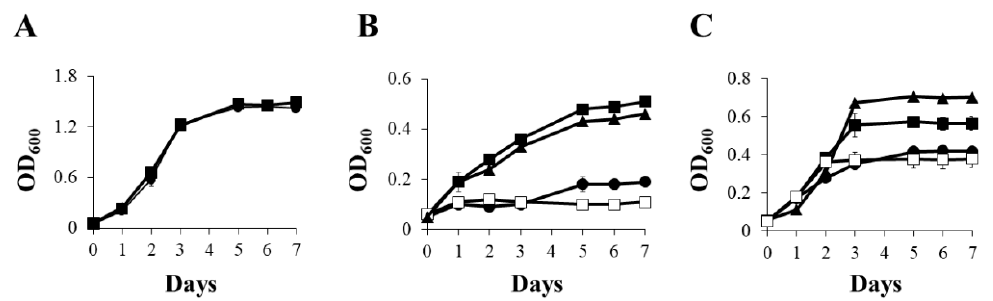
Figure 1. Growth of B. diazoefficiens 110 spc 4 in Cu limitation (Cu-L) ( ● ), Cu standard (Cu-S) ( ■ ) and high Cu (Cu-H) ( ▲ ) BVMN media under oxic ( A ), anoxic ( B ) and microoxic ( C ) conditions. In ( B , C ), growth in the Cu-S BVM medium was also included ( □ ). Error bars represent standard error between triplicates, and where not visible, these were smaller than the symbols.